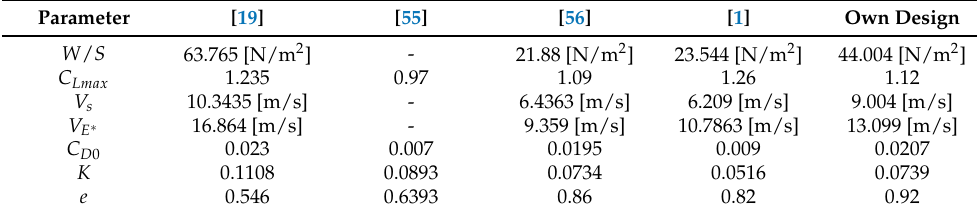
Table 8. Comparison of documented designs with our own design.